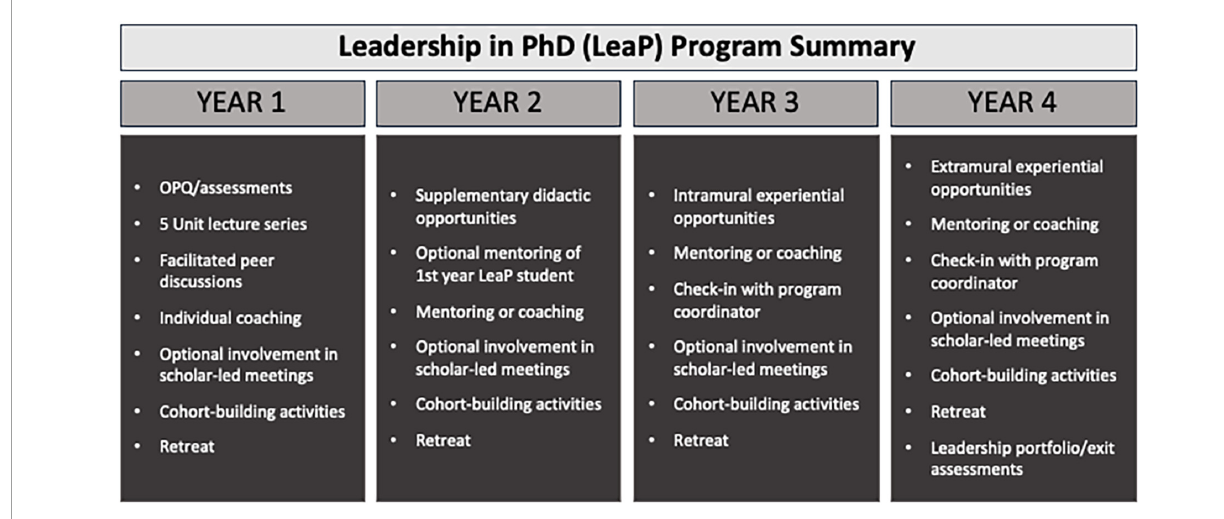
FIGURE1 Program summary. Shown (L to R) are summaries of key activities proposed for each year in the program.